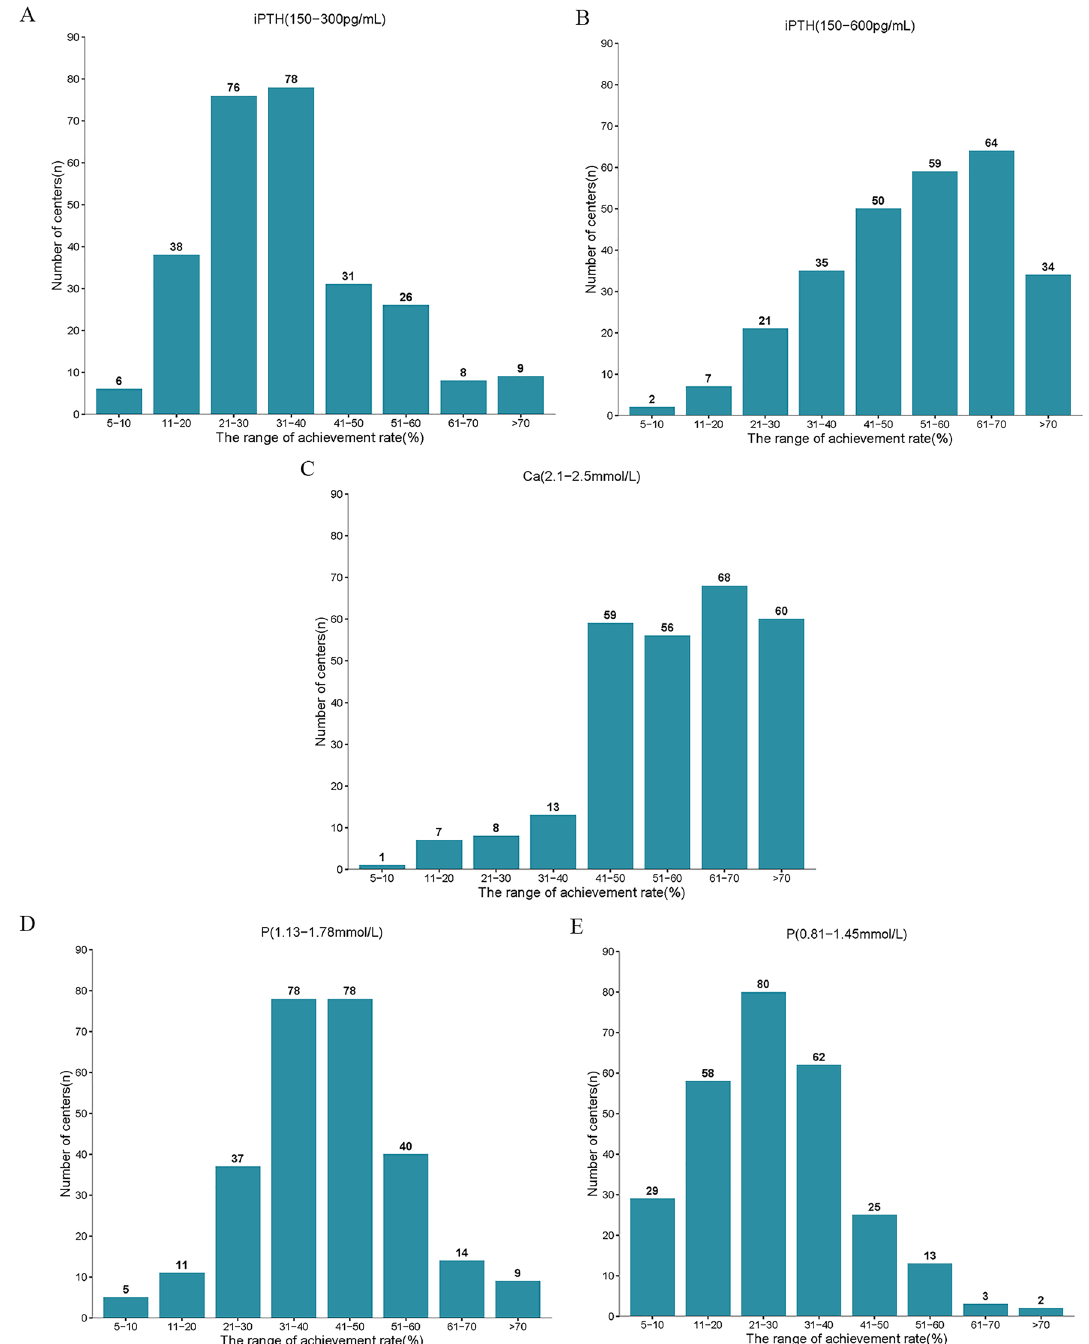
Figure 2. Distributions of iPTH, Ca, and P achievement rates in the included centers. Ca, Calcium; P, Phosphorus; iPTH, Intact parathyroid